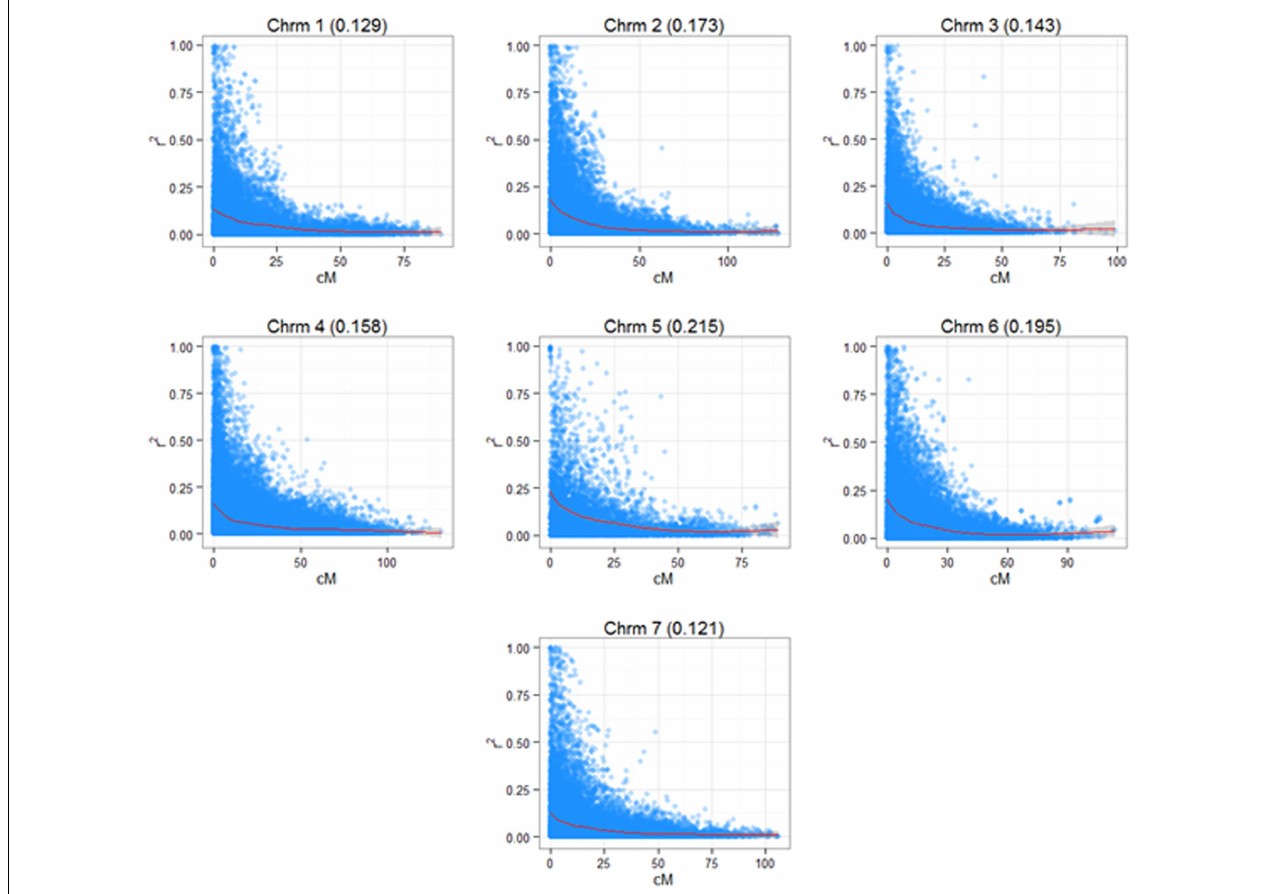
FIGURE 3 | Linkage disequilibrium (LD) in the seven chromosomes of L. perenne. The diagrams show the pairwise LD ( r 2 ) based on a consensus map derived from three mapping families (see Materials and Methods) with a superimposed cubic smoothing spline.